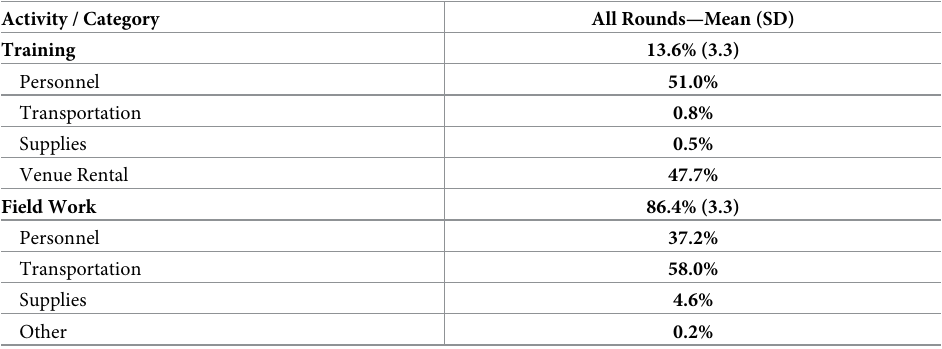
Table 4. Costs by activity and input as proportion of all costs, Amhara, Ethiopia,